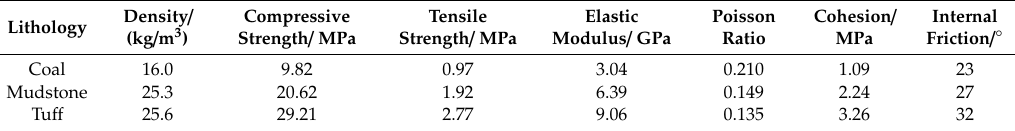
Figure 4. Stratum column and geological description at the study site [25]. Table 2. Physical and mechanical parameters of roadway surrounding rock mass [26].